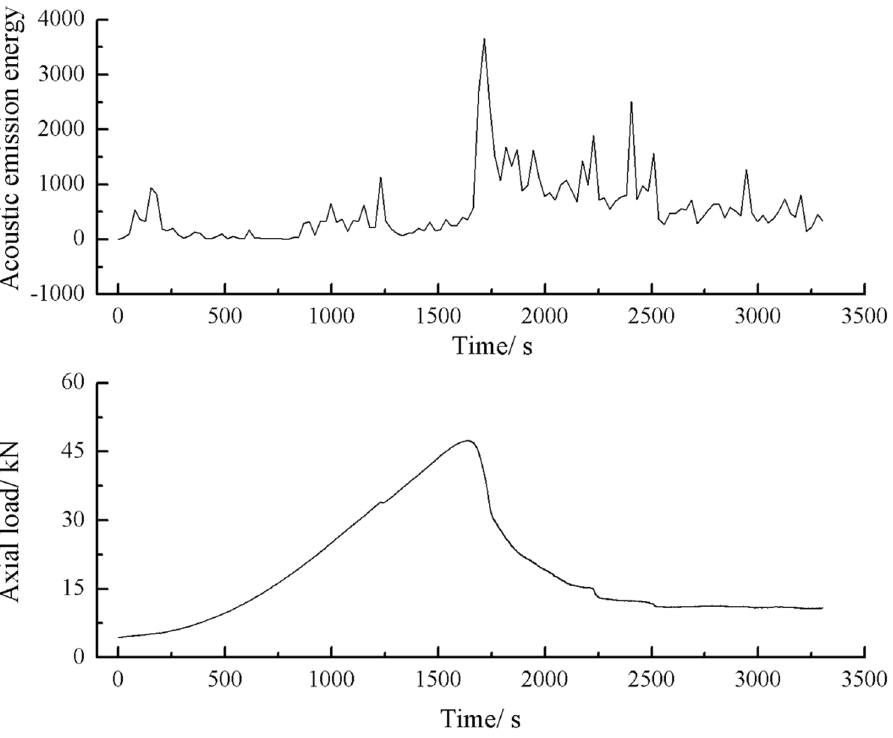
Figure 65. Acoustic emission energy-Axial load curve of the rock mass comprised of three grain size